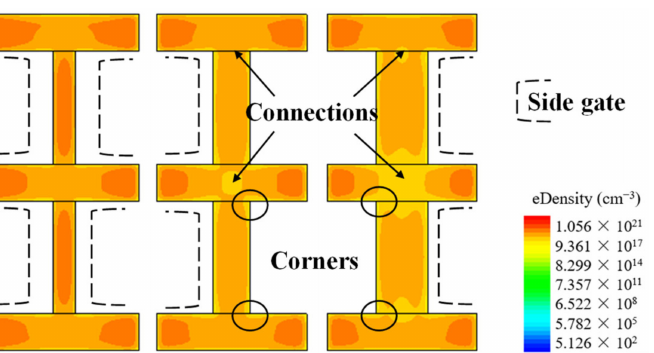
Figure 4. Electron density of channel cross sections with W IB = 3/5/7 nm (form left to right) at S NS = 15 nm at V GS = V DS = 0.7 V.